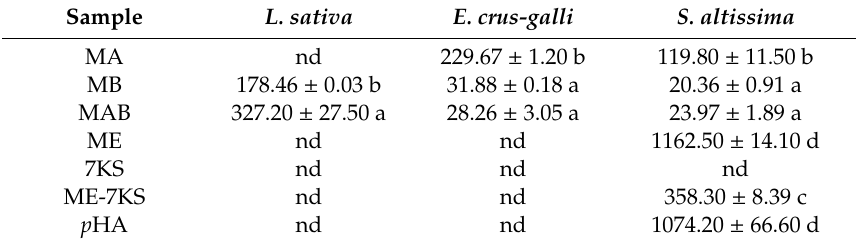
Table 1. IC 50 value ( µ g / mL) for inhibitory e ff ect of isolated compounds on germination rate of tested plants.